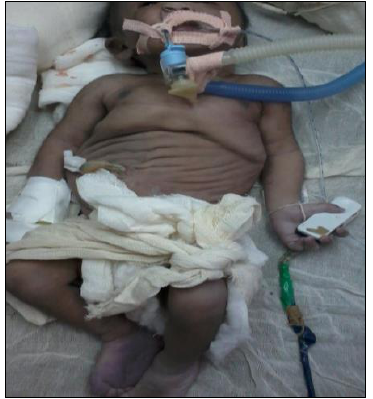
Figure 1: Baby with features of Prune belly syndrome. On examination, baby had syndromic facies-low set ears, depressed nasal bridge, receding chin, hyper- telorism, chest wall abnormality, excess of folds of skin on anterior abdominal wall (prune), (Fig. 1) epispadias, bilateral cryptorchidism, and Right congenital talipes equino varus (TEV) deformity.